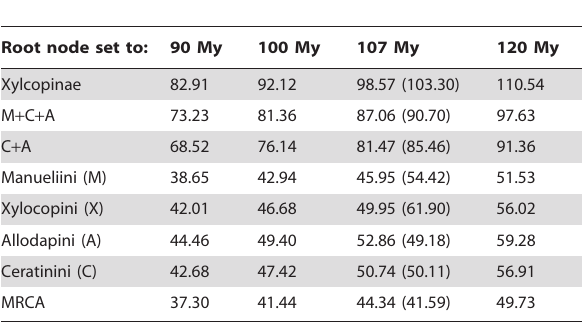
Table 1. Age estimates of Xylocopinae root age and tribe origins obtained from a relaxed clock